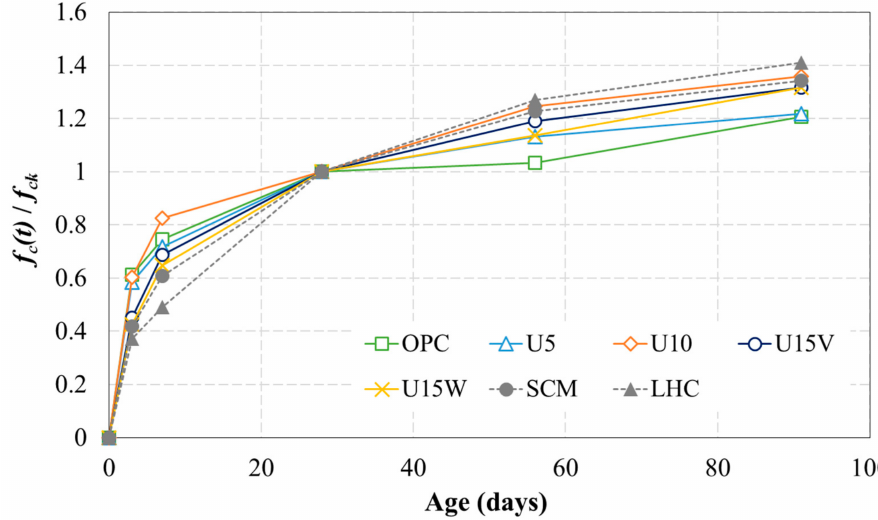
Figure 4. Typical compressive strength gain ratio of the concrete